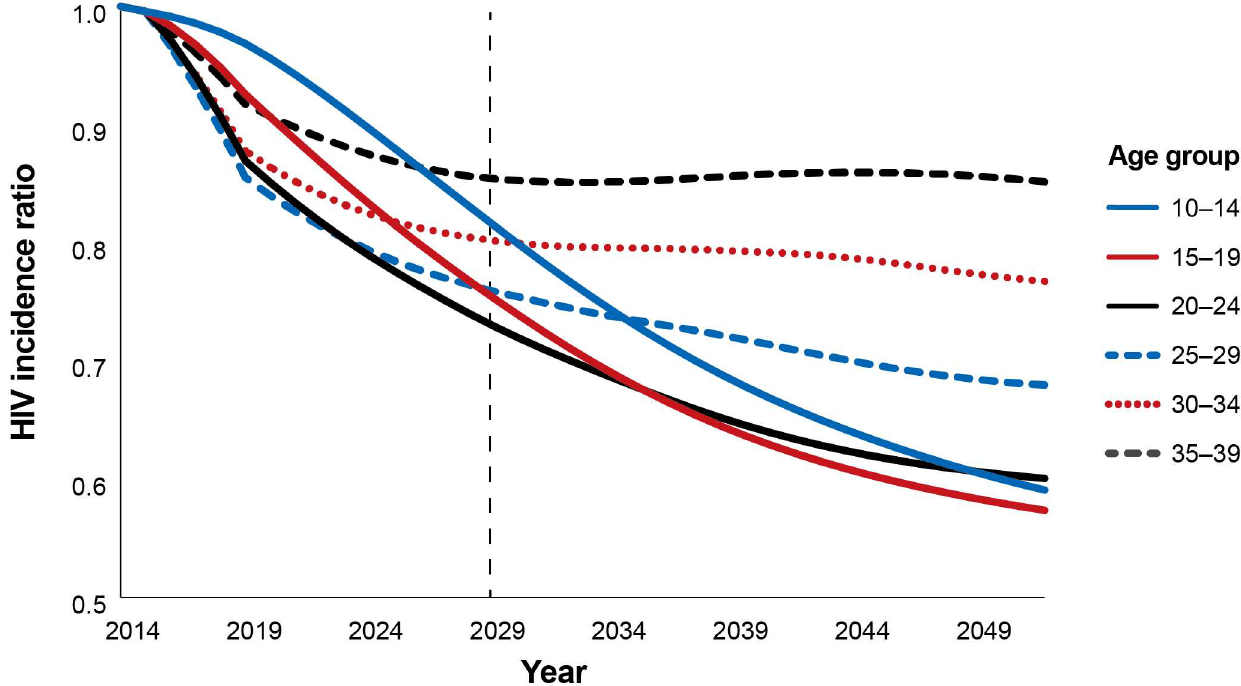
Fig 2. Reduction in HIV incidence with provision of VMMC to males, by age group, 2014–2050. The HIV incidenceratio represents the incidence in the scale-up scenario divided by the incidencein a population where circumcision is not scaled up over baselinelevels. HIV incidence is in the entire population—males and females. Each line represents the HIV incidence ratio under a scenario in which only the indicated five-year age group is circumcised. In each age group, MC is scaled up to 80% coverage 2014–2018 and maintained at that level from 2018 forward. The dashed vertical line represents a 15-year period from the base